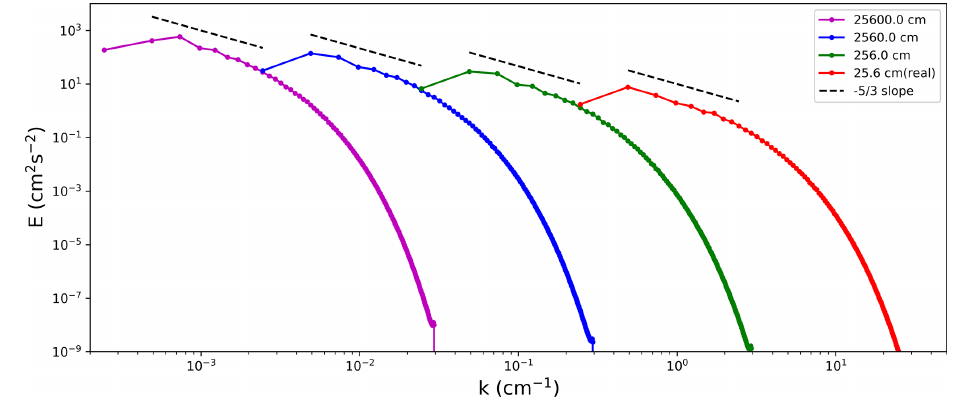
Figure 1. Comparison of energy spectra for real and scaled-up DNS.